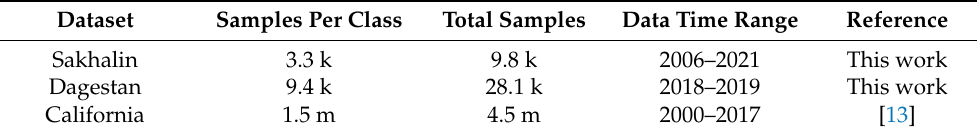
Table 2. Summary of local earthquake datasets. Each sample is 4 s long at 100 Hz (400 points in total). The data were high-pass filtered above 2 Hz, and a trend was removed.